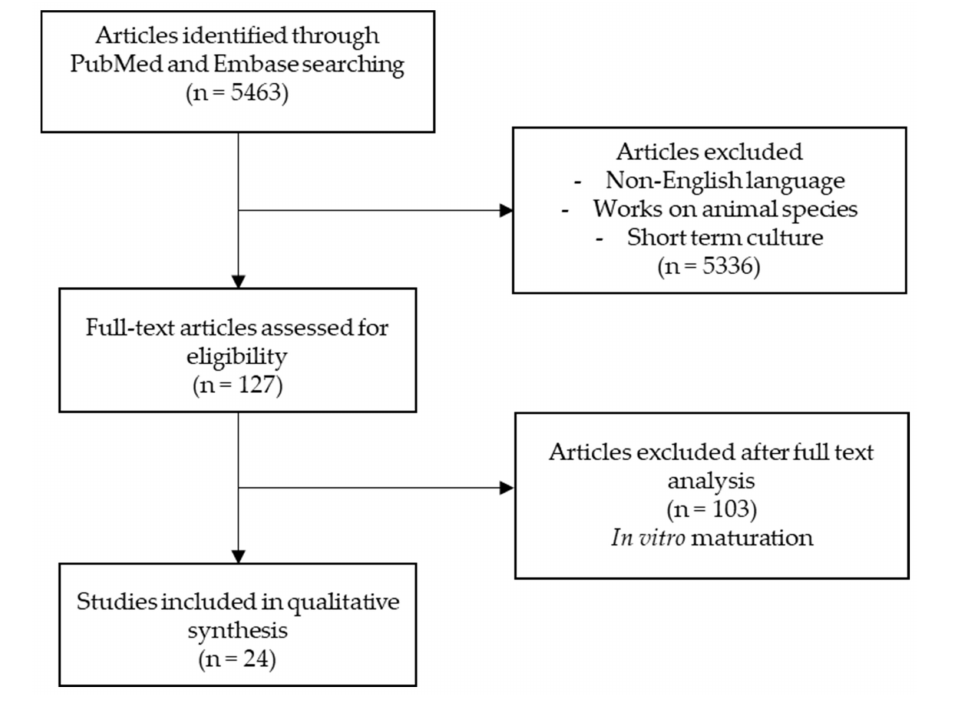
Figure 1. Flow chart of the included studies and search strategy.